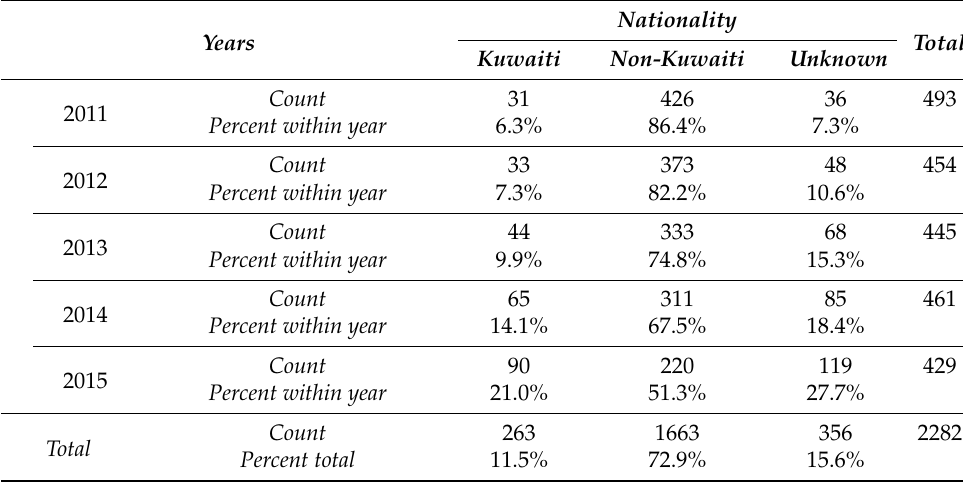
Table 3. Total number of traffic-related deaths by nationality from 2011 to